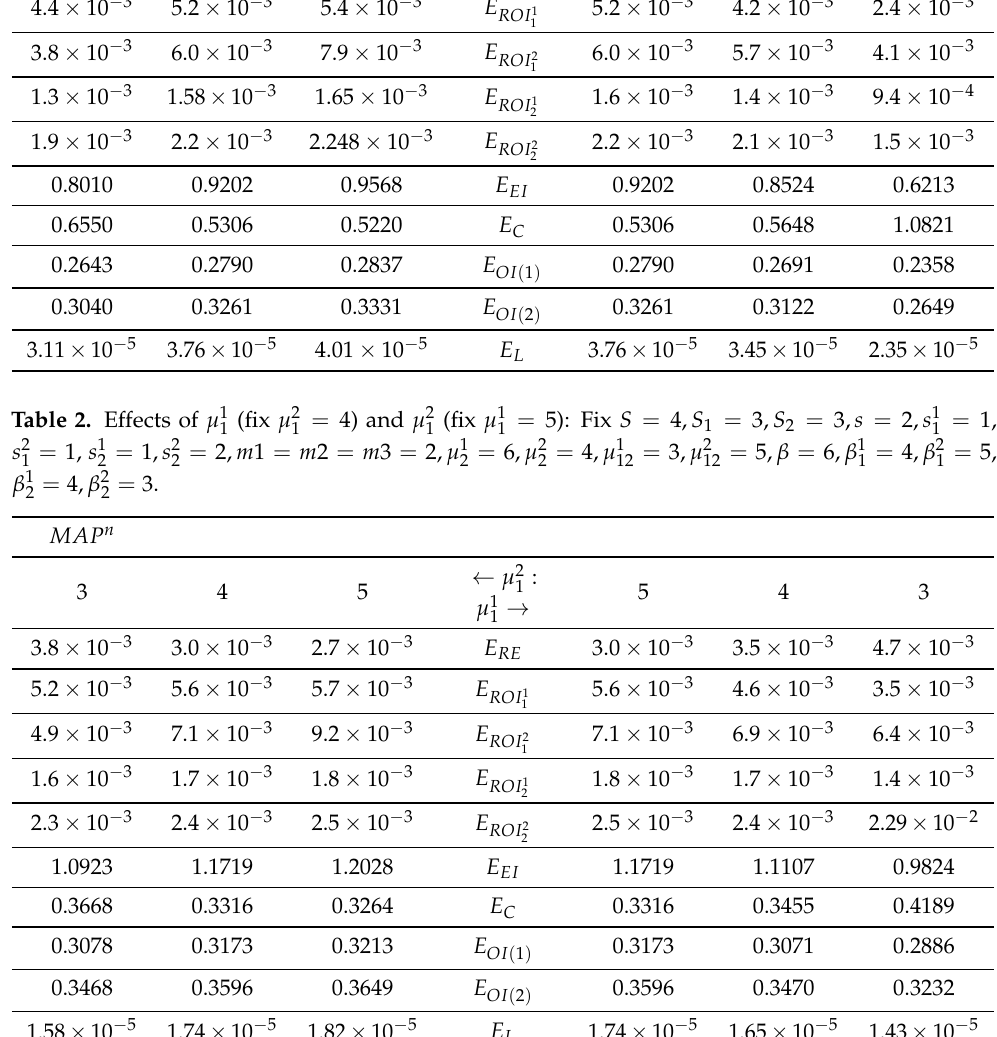
= 4) and µ 2 (fix µ 2 1 1